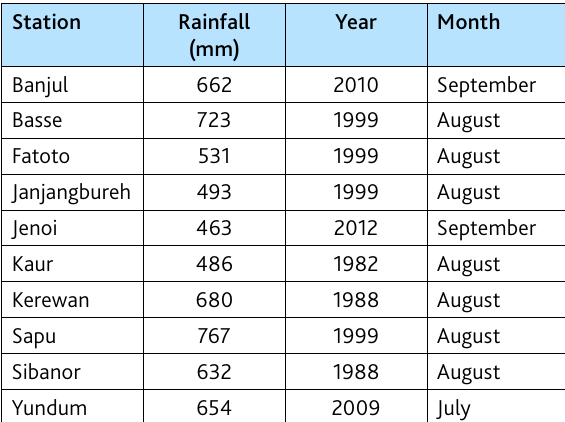
Table 3. Highest station rainfall received during the study